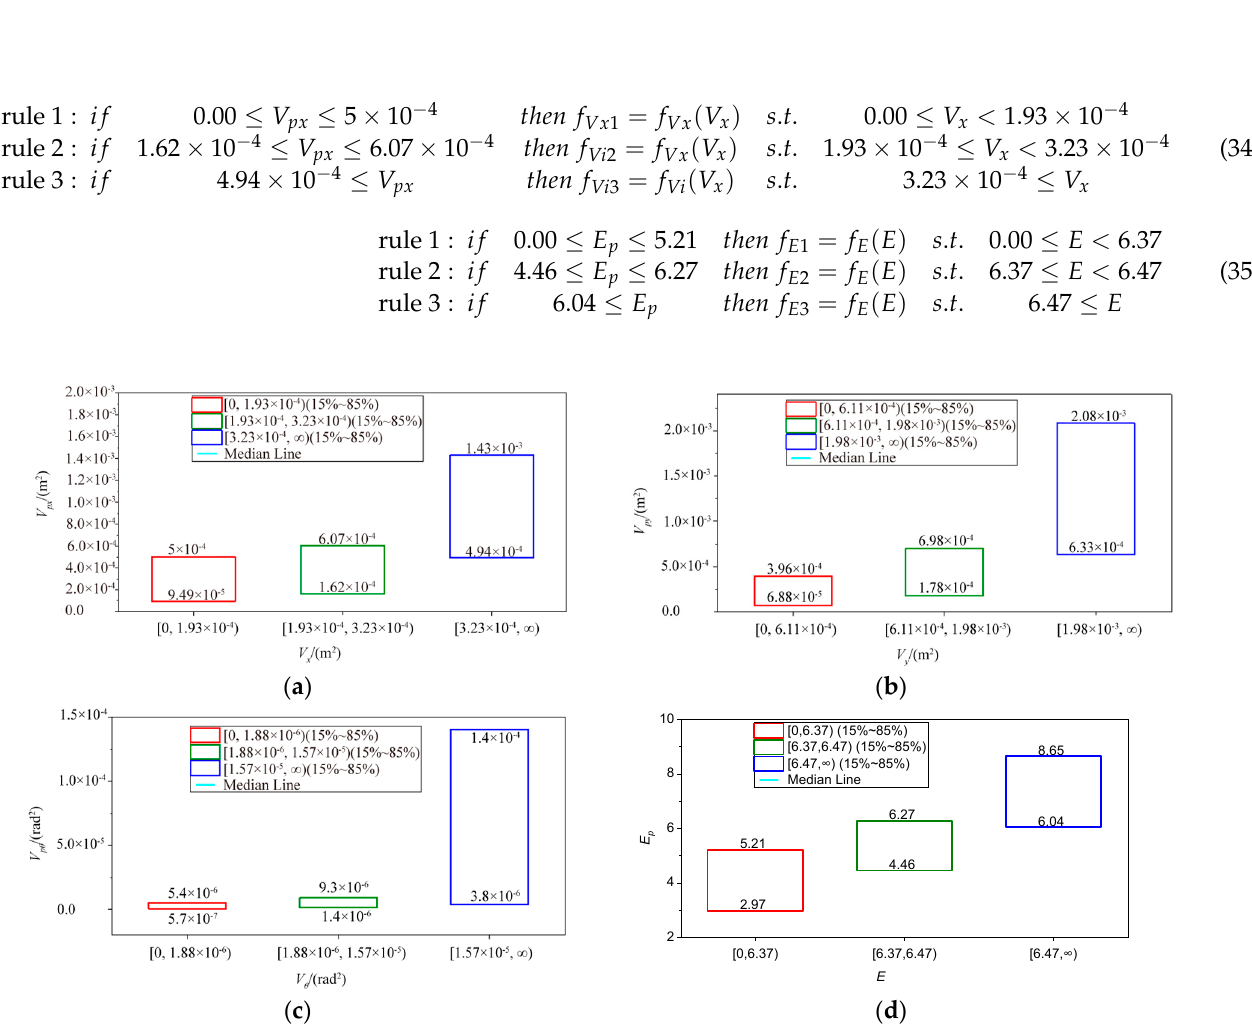
Figure 4. The distribution of V p and E p in the different ranges of V and E . ( a ) V px in the different ranges of V x . ( b ) V py in the different ranges of V y . ( c ) V p θ in the different ranges of V θ . ( d ) E p in the different ranges of E .